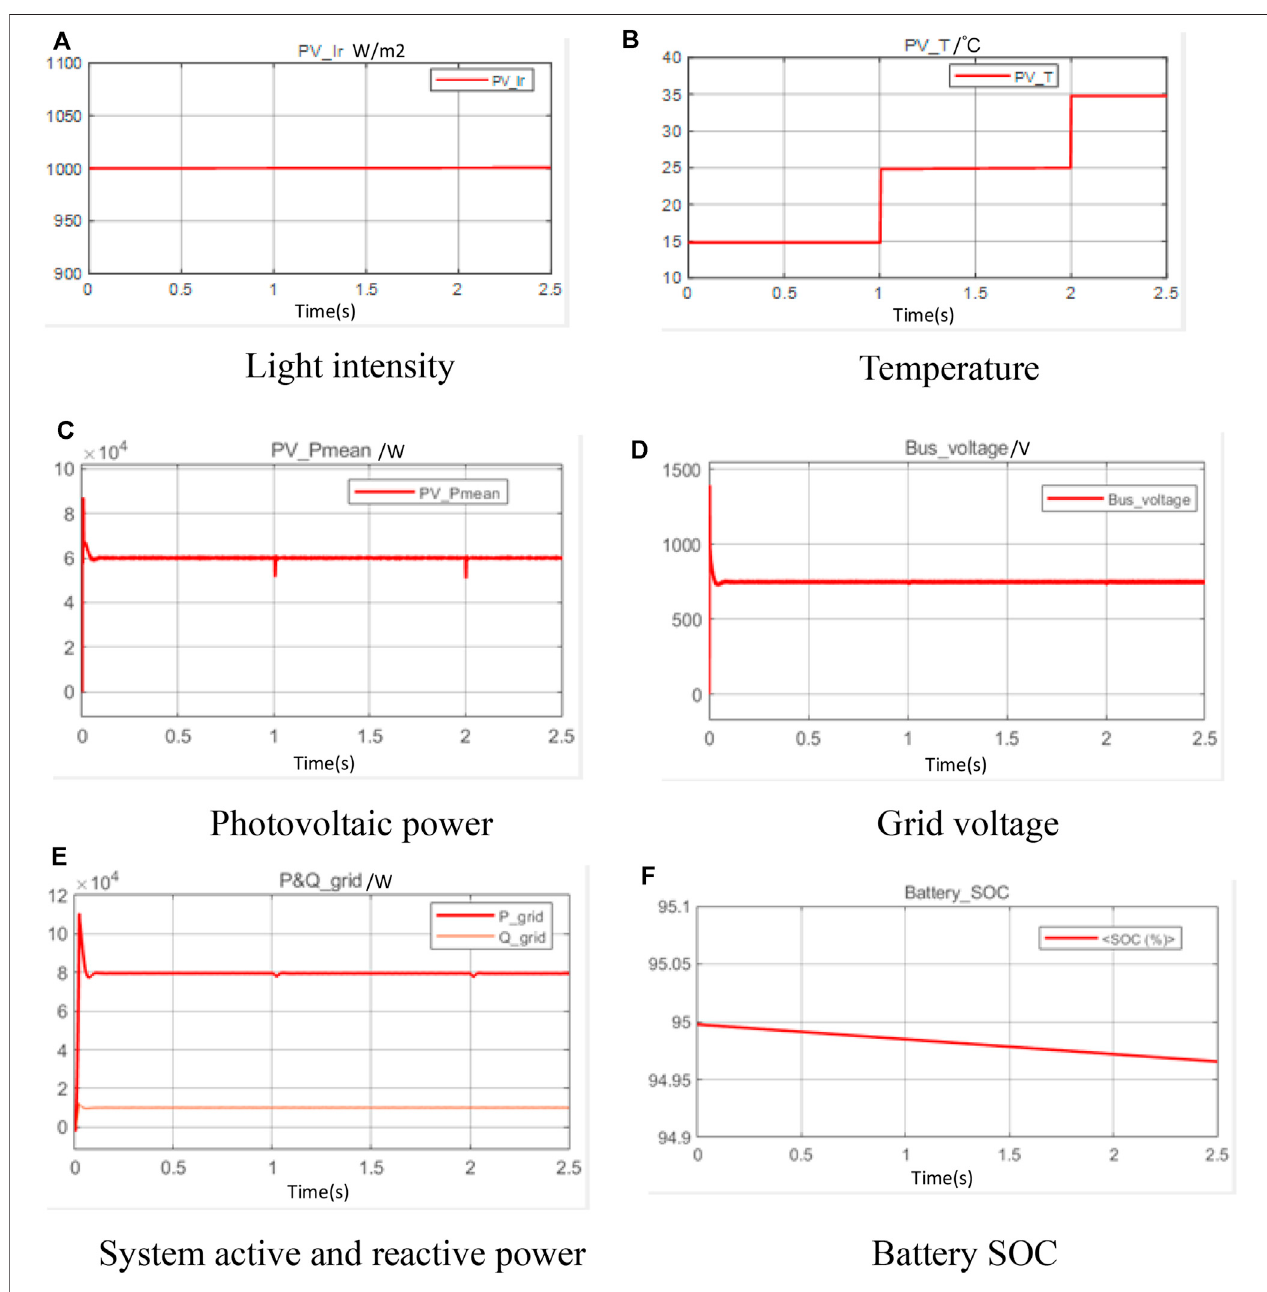
FIGURE 8 | Dynamic response in case 1. (A) Light intensity (B) Temperature (C) Photovoltaic power (D) Grid voltage (E) System active and reactive power (F) Battery SOC.